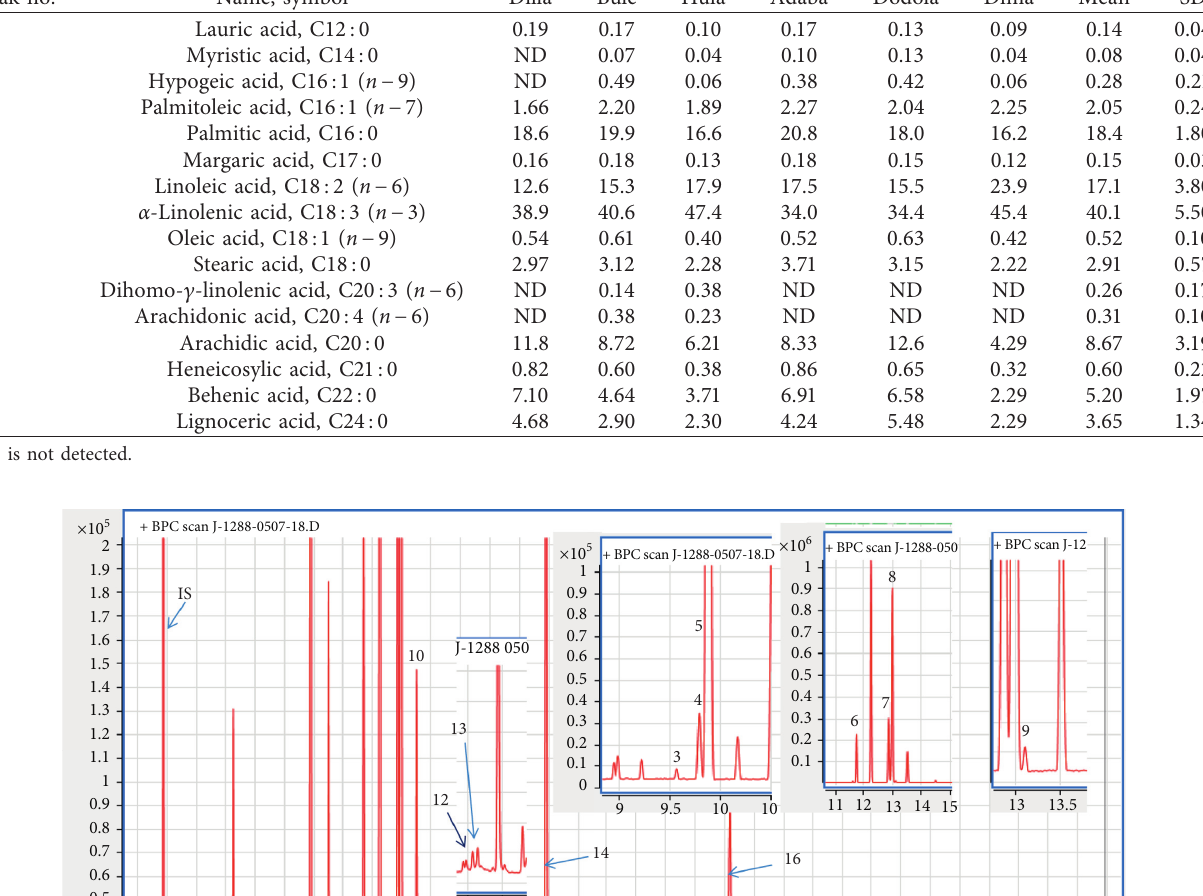
Table 3: Relative percentage composition of fatty acids detected in leaves of Urtica simensis collected from six different districts in Ethiopia. Peak no.